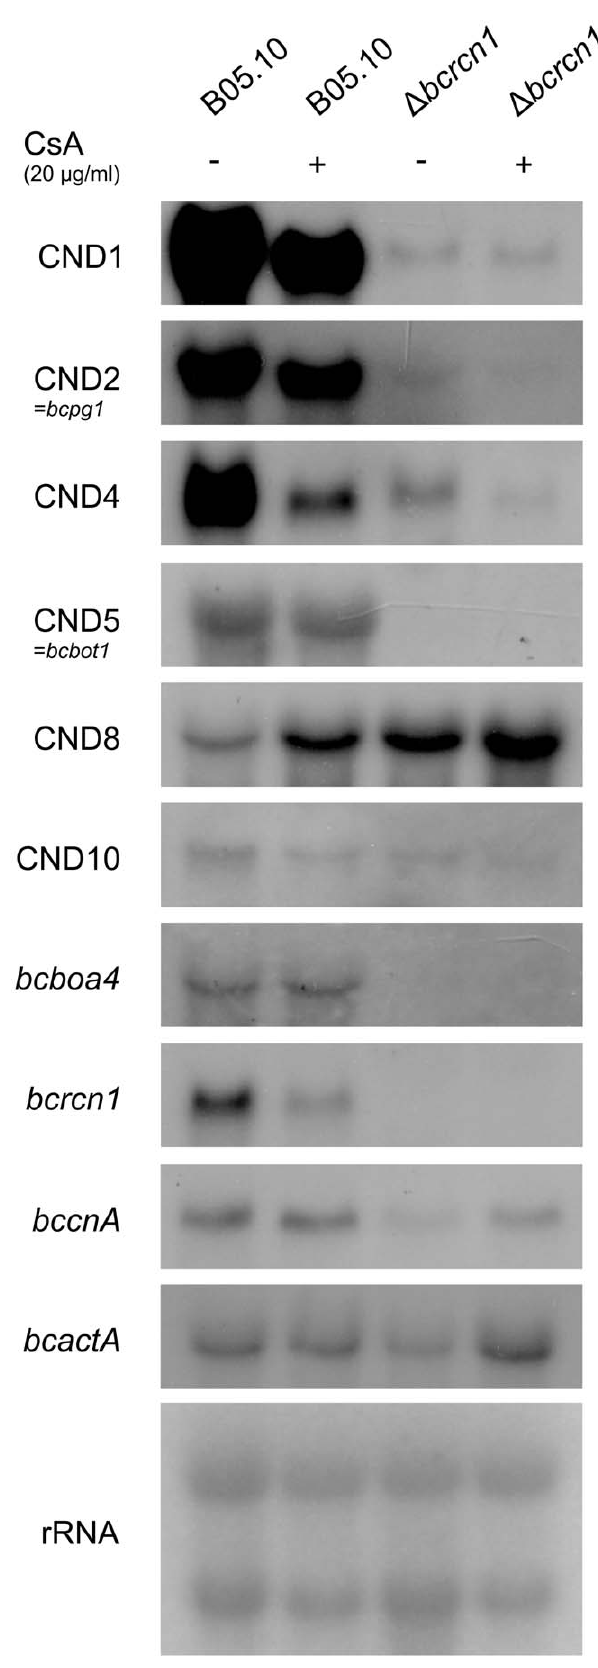
Figure 7. Expression studies in the wild-type and the D bcrcn1 mutant strain. The wild-type B05.10 and the D bcrcn1 mutant were grown for 72 h in liquid culture (SISLER medium) and then moved to fresh cultures without ( 2 ) or with ( + ) 20 m g/ml of the calcineurin- inhibitor cyclosporine A (CsA). The northern blot was hybridized to radioactively labeled probes of several BcCnA/BcCrz1-dependent genes (CND-genes [30], CND5= bcbot1 as a botrydial biosynthesis gene, bcboa4 as a botcinic acid biosynthesis gene), bccnA and bcrcn1 . Loading controls: bcactA and